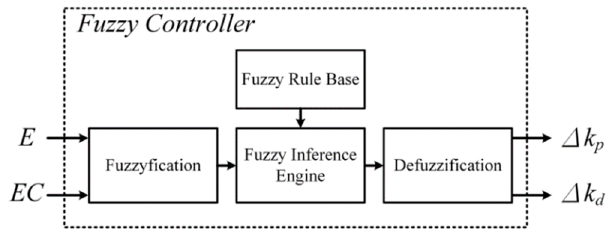
Figure 2. Fuzzy control system architecture diagram.